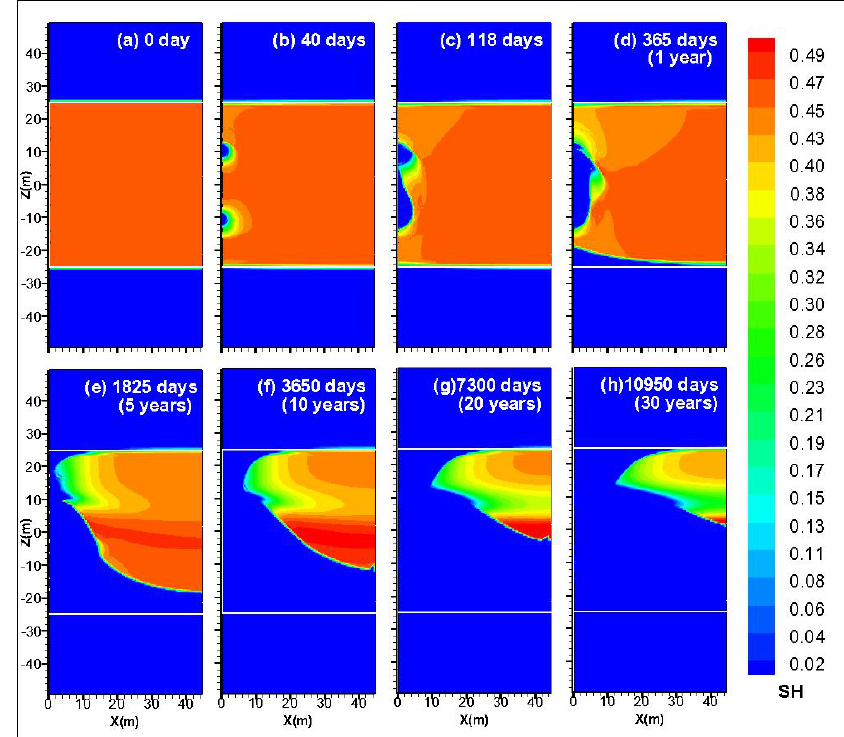
Figure 6. Evolution of the spatial distribution of S (the Reference